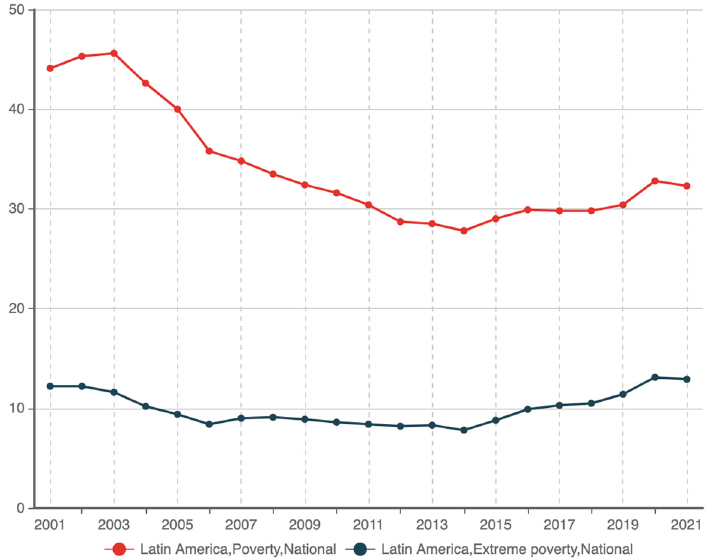
Figure 1. Population living in extreme poverty and poverty by geographical area, 2001–2021. Source: (CEPAL 2022).